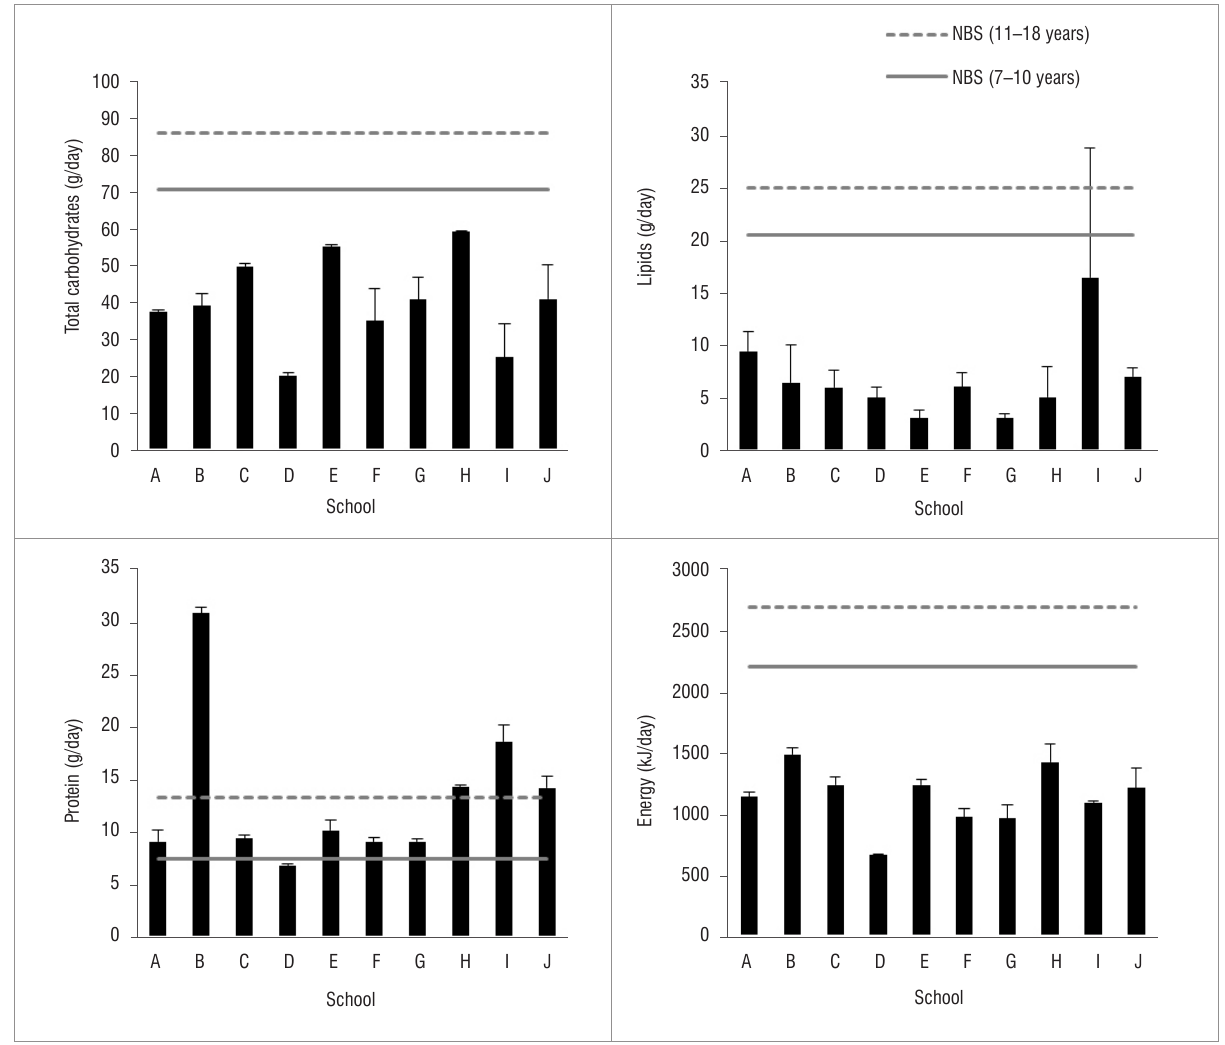
Mean macronutrient values of meals sampled at various schools participating in the National School Nutrition